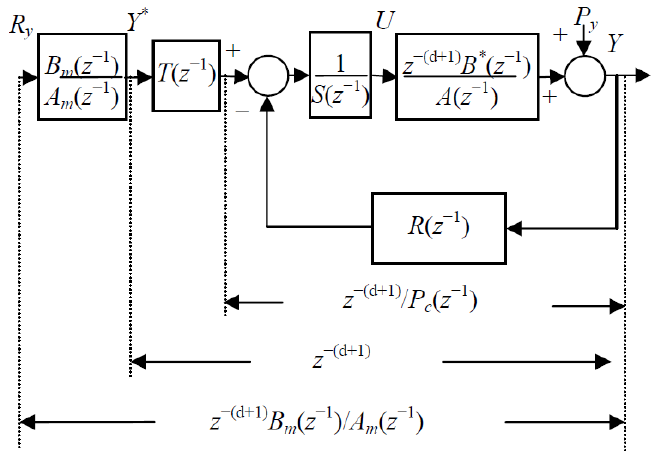
Figure 5. Block-diagram of a RST digital